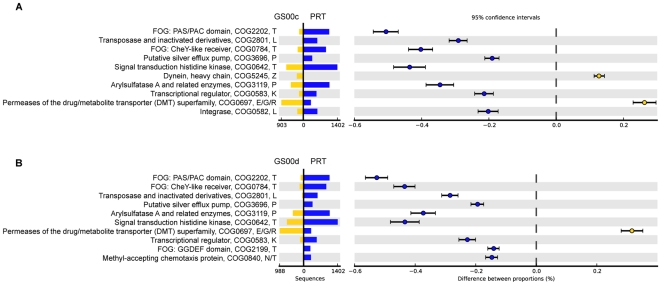
Metagenomic profile comparisons of COG families for the PRT and Sargasso Sea nonredundant proteins.Extended error bar plot for the top ten COGs, ordered according to significance, identified in the PRT compared to (A) GS00c and (B) GS00d, indicating the effect size and associated confidence intervals for each significantly different COG family. COG descriptions are listed along with the COG category letters, E, amino acid transport and metabolism; G, carbohydrate transport and metabolism; K, transcription; L, replication, recombination, and repair; N, cell motility; P, inorganic ion transport and metabolism; R, general function prediction only; T, signal transduction mechanisms; and Z, cytoskeleton.